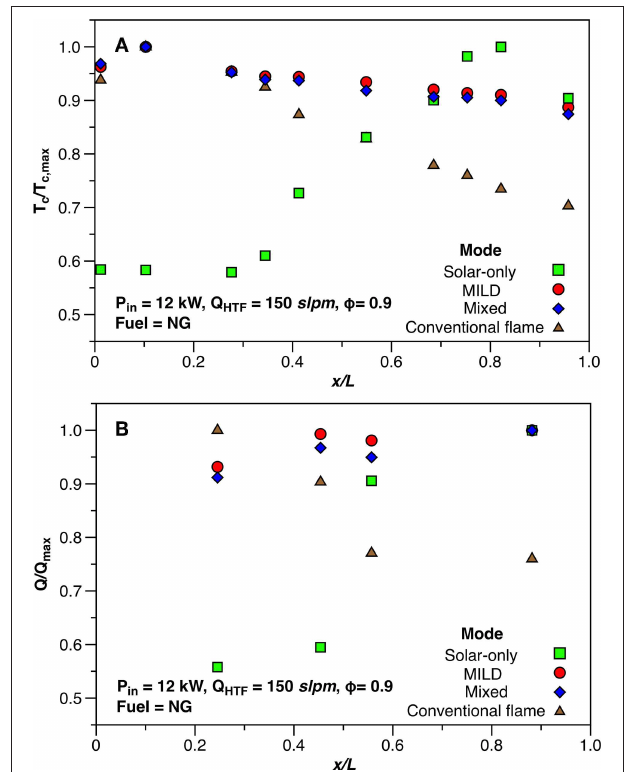
FIGURE 5 | Axial distribution for all modes of operation of (A) the wall cavity temperature normalized by its maximum value, T c /T c , max , and (B) heat flux through HTF coils normalized by its maximum value, Q/Q max . Conditions for combustion operations: P in = 12 kW, φ = 0.9, Q HTF = 150 slpm, fuel = NG. Data from Chinnici et al. (2018a,b,